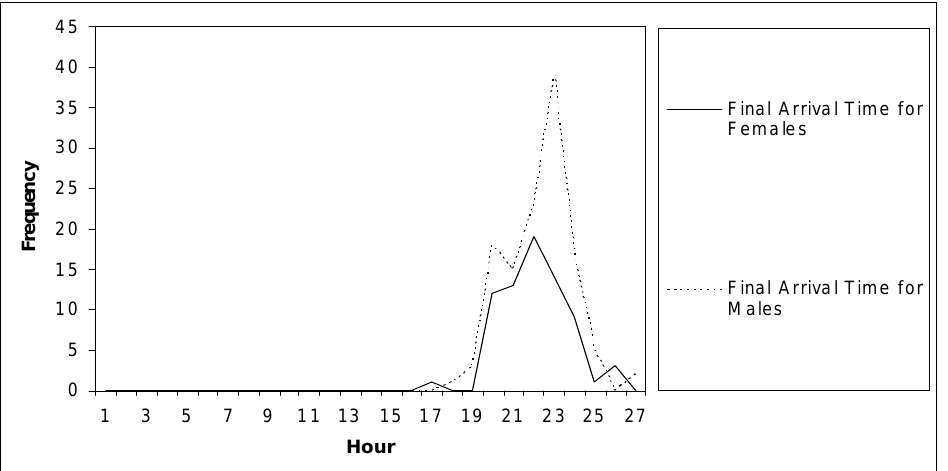
Figure 4. Distribution of final arrival at home for male and female workers, of activity pattern with out-of- home activities after dinner at home